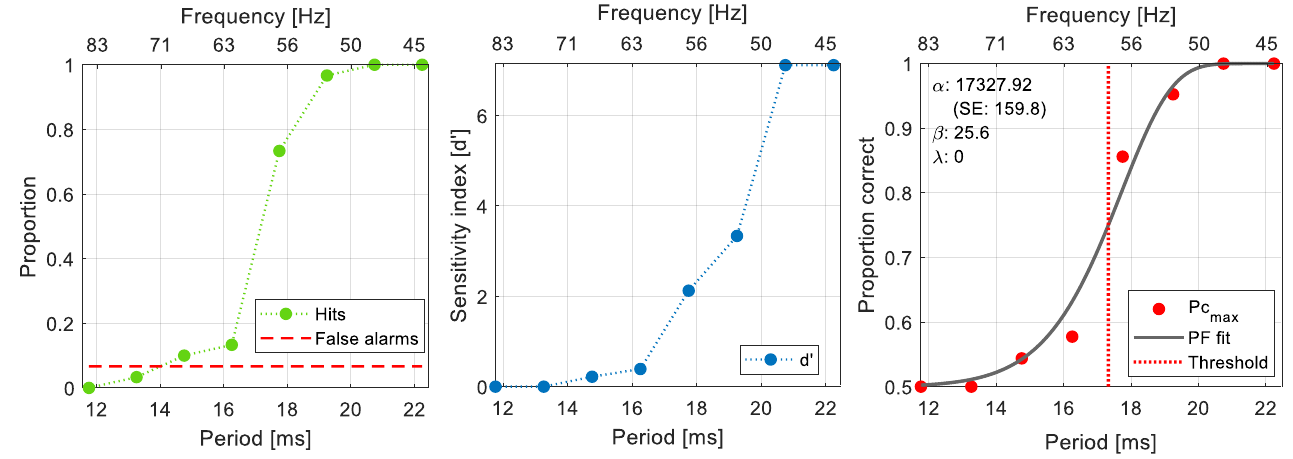
Figure 3. Example of the results obtained for one participant at one retinal illuminance level. The left panel shows the proportion of hits, as a function of the period of flicker, and the proportion of false alarms. The middle panel shows the calculated d’ as a function of the period of flicker presented. Note that when the proportion of hits is lower than the proportion of false alarms, d’ is set to 0. The right panel shows the unbiased proportion correct (PC max ) as a function of the period of flicker, the Quick psychometric function fitted, and the estimated threshold. In all panels the corresponding frequency of flicker is displayed in the top abscissa.